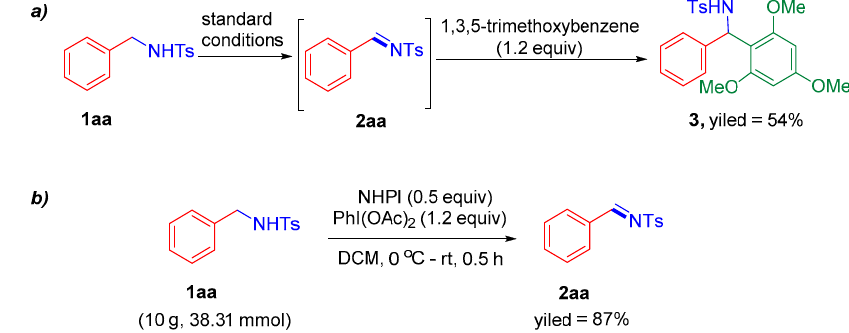
Figure 4. One-pot Friedel–Crafts arylation of sulfonylimine and Gram-Scale reaction.